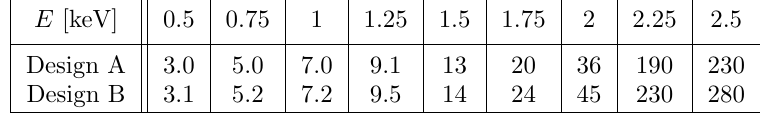
Table 1. The dependence of theoretical sensitivity (in units of 10 − 11 erg cm − 2 s − 1 ) per 1 ks exposure on photon